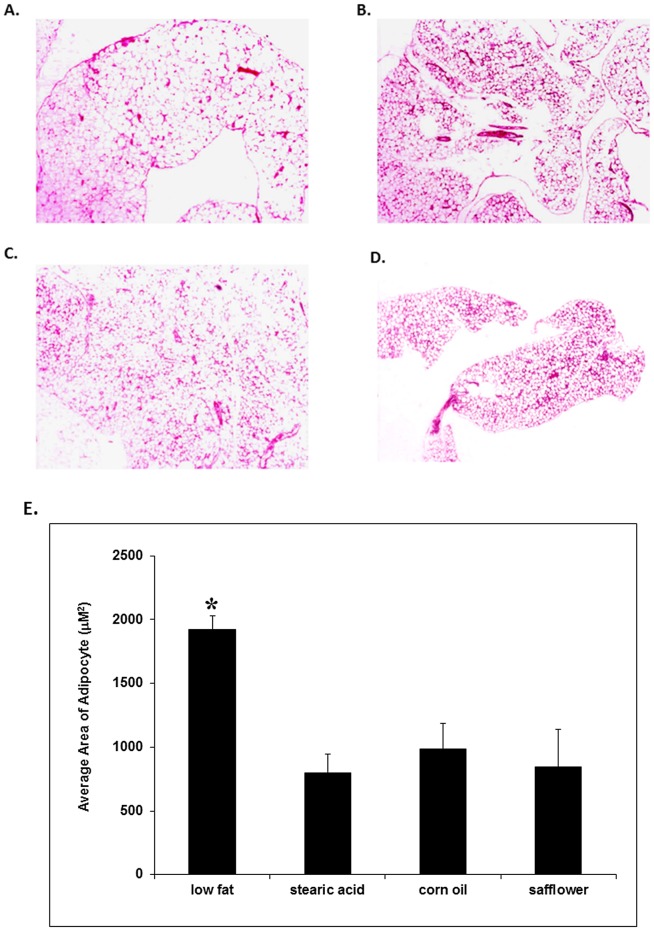
The size of abdominal adipocytes in dietary groups.Representative images of histopathologic sections of abdominal fat from mice fed: a low fat diet (A), corn oil diet (B), safflower oil diet (C) or stearic acid diet (D) All images are at the same low power (25x) magnification. (E) Mice on the low fat diet had significantly larger adipocytes as compared to all other groups (*, p<0.01).